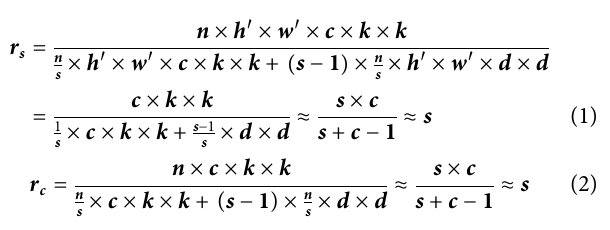
Frontiers in Materials |